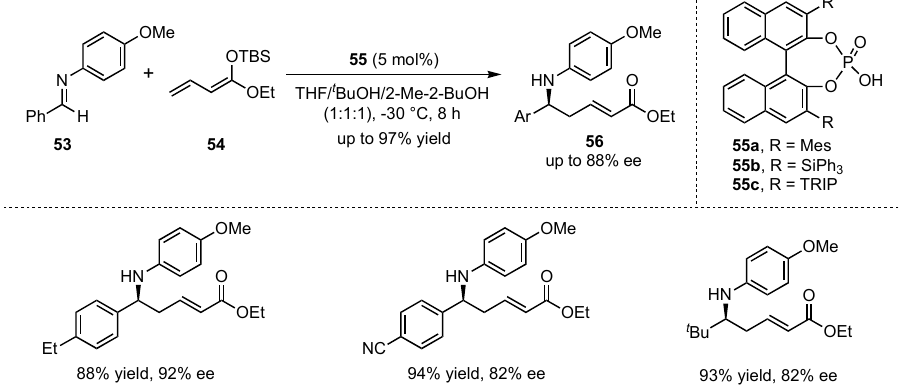
Scheme 15. Brønsted acid organocatalyzed asymmetric VMMnR’s between aldimines and linear silyl-dienolates by Schneider et al. [48]. silyl-dienolates by Schneider et al.